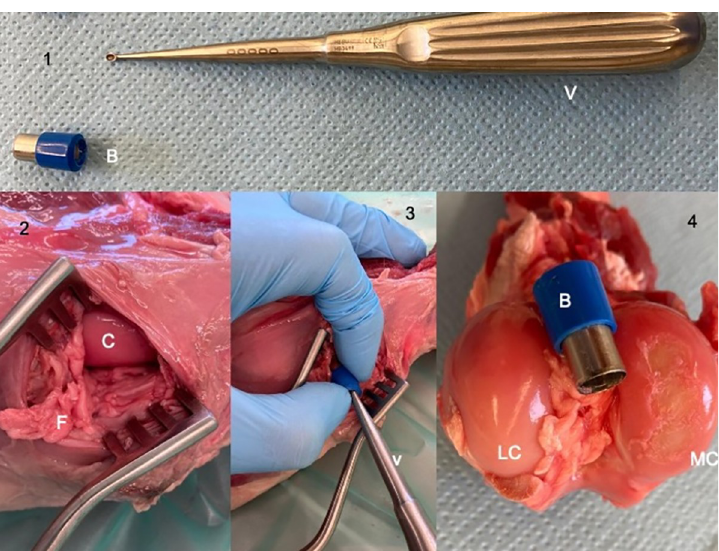
Fig 3. Procedure of creation of cartilage default. (1) The distal and cutting part was sawed from a biopsy punch (B). (2) After incision of the subcutis and joint capsule, the medial condyle (C) of the femur was exposed. Fat (F) was removed from the joint cavity. (3) The biopsy punch (B) was deeply entered into three adjacent sites of cartilage in the axial aspect of the medial condyle of the femur. The Volkman curette (V) was used to remove cartilage. Then the joint capsule was sutured and tests were performed. (4) Picture 4 illustrates the three cartilage defects on the medial condyle (MC) at gross anatomy dissection. LC = lateral condyle.